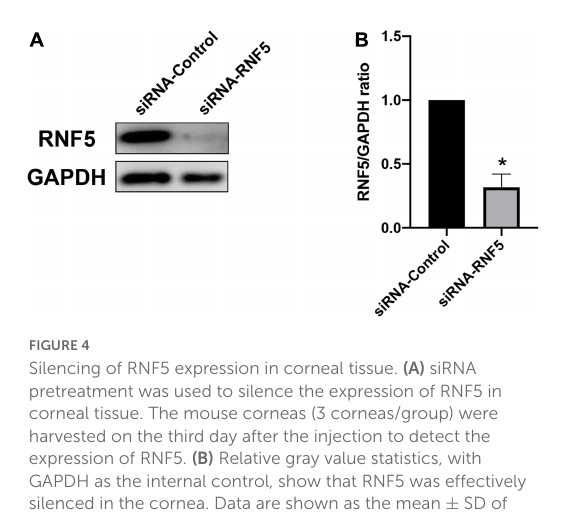
FIGURE4 Silencing of RNF5 expression in corneal tissue. (A) siRNA pretreatment was used to silence the expression of RNF5 in corneal tissue. The mouse corneas (3 corneas/group) were harvested on the third day after the injection to detect the expression of RNF5. (B) Relative gray value statistics, with GAPDH as the internal control, show that RNF5 was effectively silenced in the cornea. Data are shown as the mean ± SD of three independent experiments. * P <